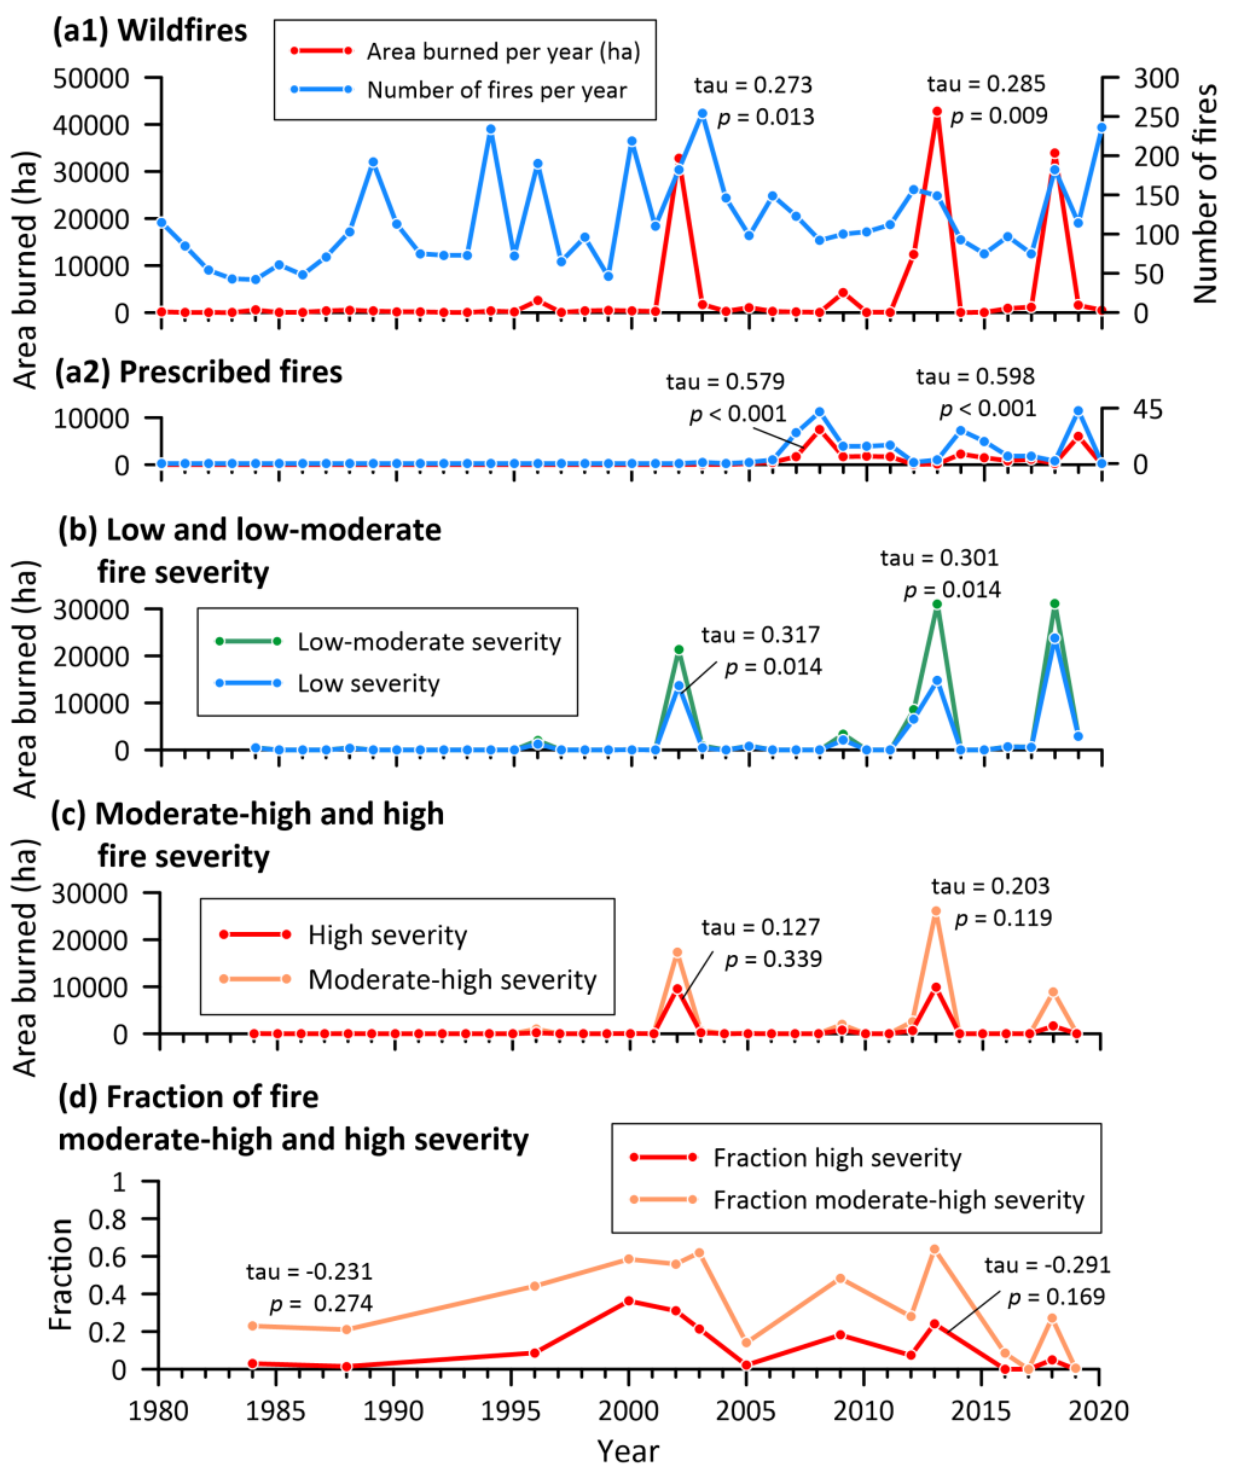
Figure 3. Trends in ( a1 ) wildfires, ( a2 ) prescribed fires, and ( b ) low and low-moderate fire severity, ( c ) moderate-high and high fire severity, and ( d ) fraction of fire that was moderate-high and high severity in wildfires from 1980 to 2020 in the San Juan